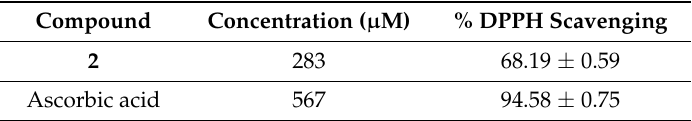
Table 7. Result of in vitro antioxidant activity of the compound 2 with reference to the